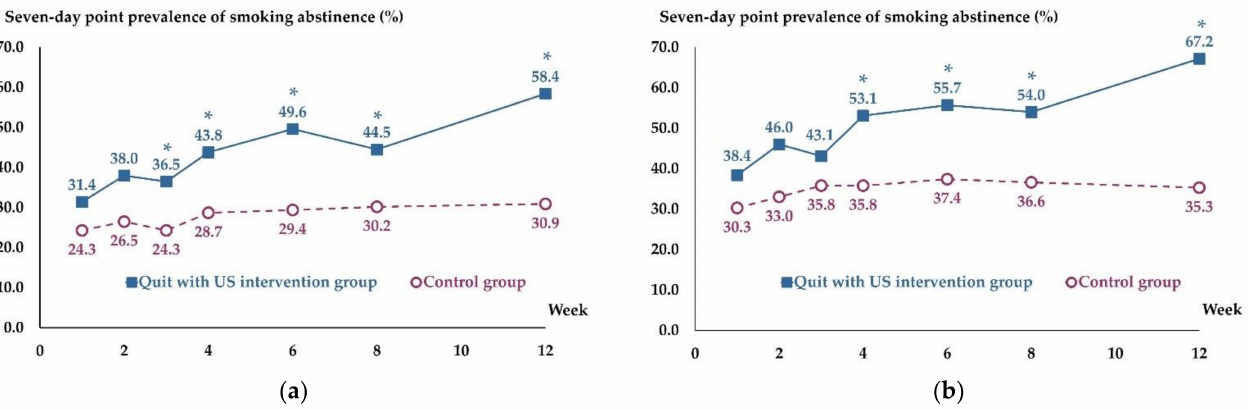
Figure 3. Seven-day point prevalence of smoking abstinence at 1, 2, 3, 4, 6, 8, and 12 weeks